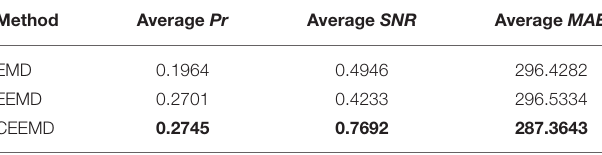
TABLE 1 | Evaluation indexes of different decomposition methods.